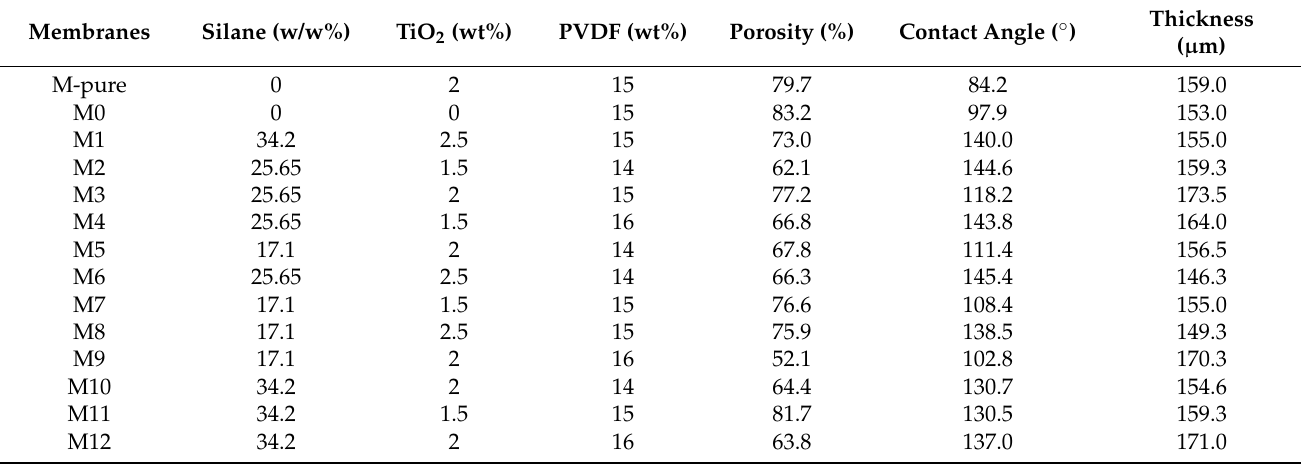
Table 2. Combinations of fabricating conditions for PVDF composite